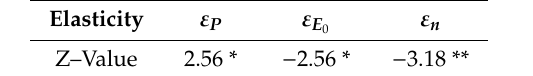
Table 4. MK trend test Z–Value of elasticity.